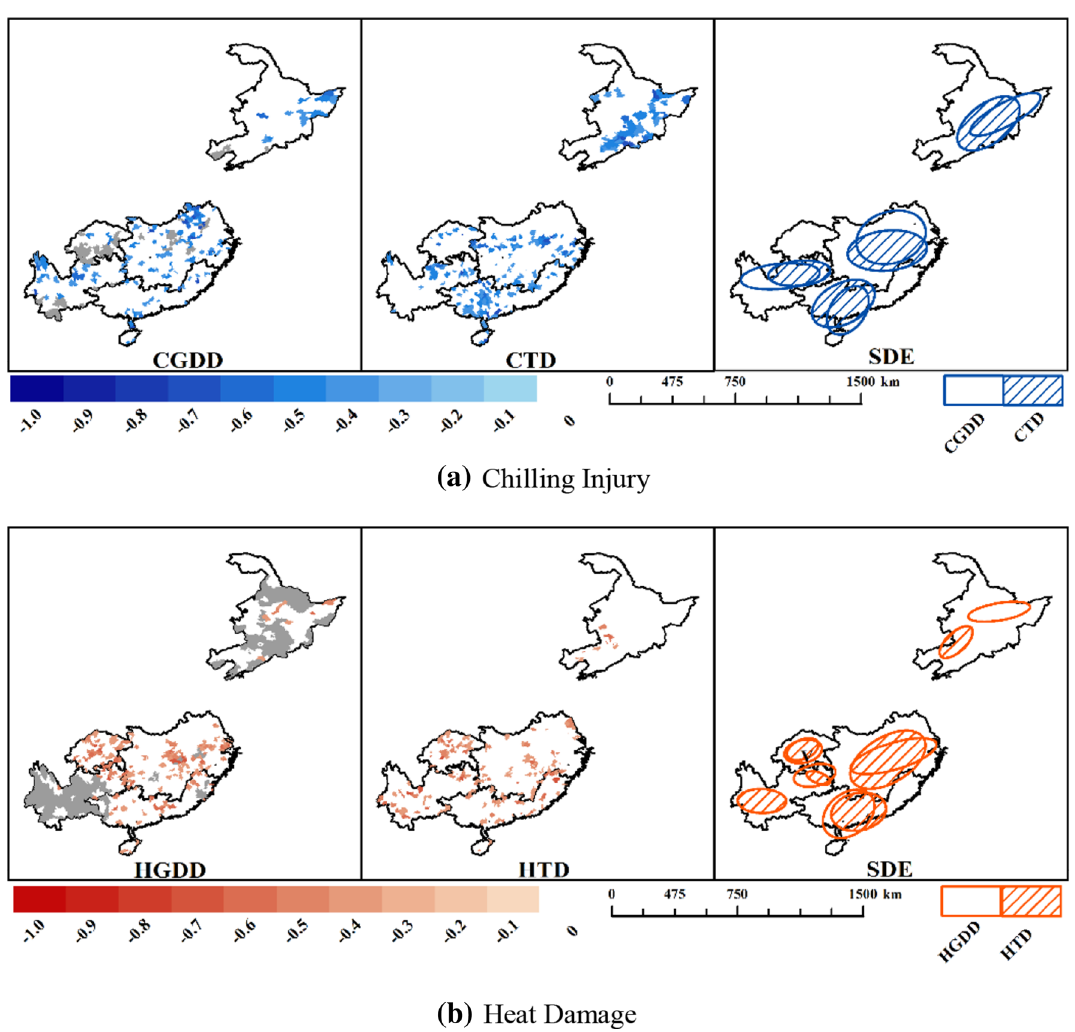
Fig. 4 Spatial distribution of insurable counties for chilling injury and heat damage of rice: a chilling injury; b heat damage; and c SDE. Open ellipses represent absolute weather indices and shaded ellipses